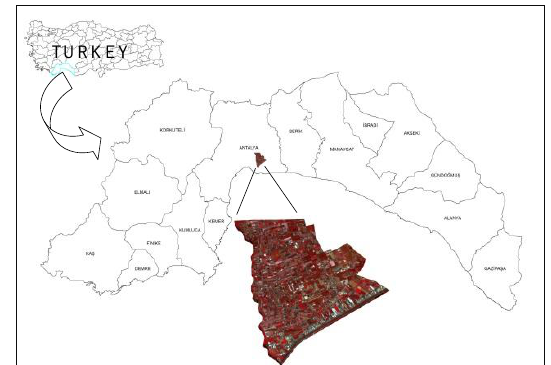
Figure 1. The location of the study